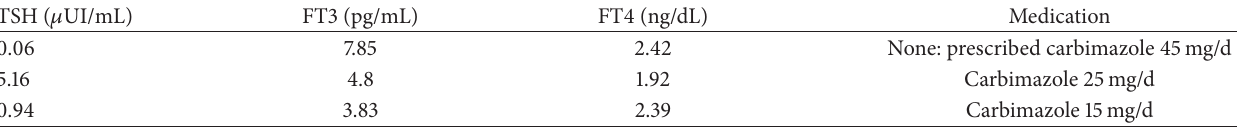
Table 1: TSH, FT3, and FT4 levels and antithyroid medication in the first patient, before thyroidectomy. TSH ( 𝜇 UI/mL) FT3 (pg/mL) FT4 (ng/dL) Medication 0.06 7.85 2.42 None: prescribed carbimazole 45mg/d 5.16 4.8 1.92 Carbimazole 25 mg/d 0.94 3.83 2.39 Carbimazole 15mg/d Normal values: TSH = 0.4–4 𝜇 UI/mL. FT3 = 1.8–4.2pg/mL. FT4 = 0.8–1.9ng/dL.